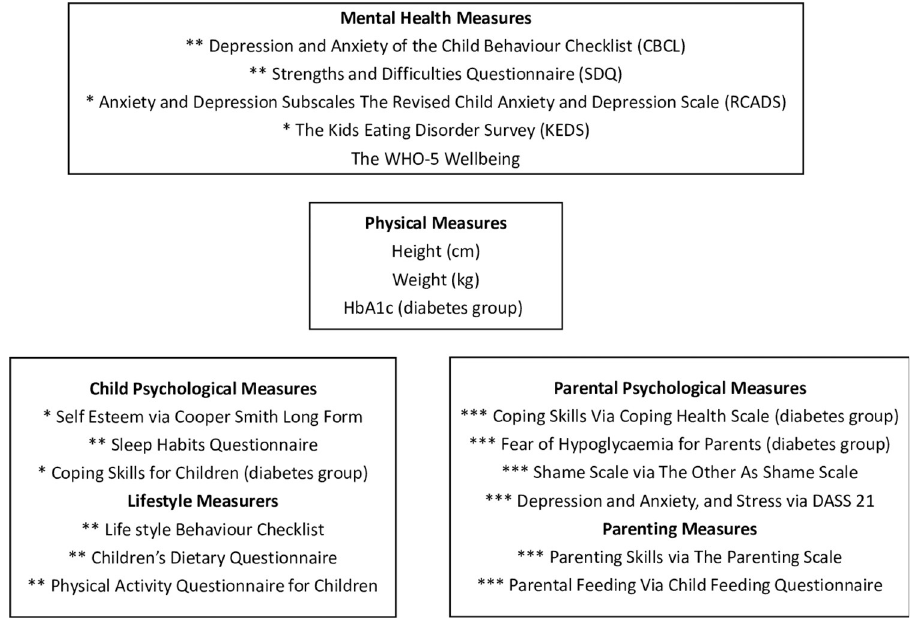
Fig 1. Measures used in the study. Note : � measures completed by children, �� child measures completed by parents, ��� measures completed by parents. The WHO-5 Wellbeing measure was completed by both parents and children.